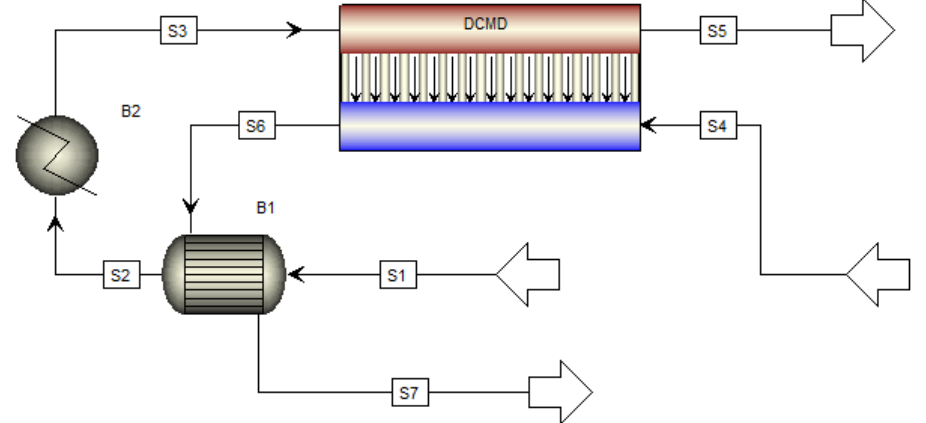
Figure 5. Flowchart of a base case DCMD-based desalination process.